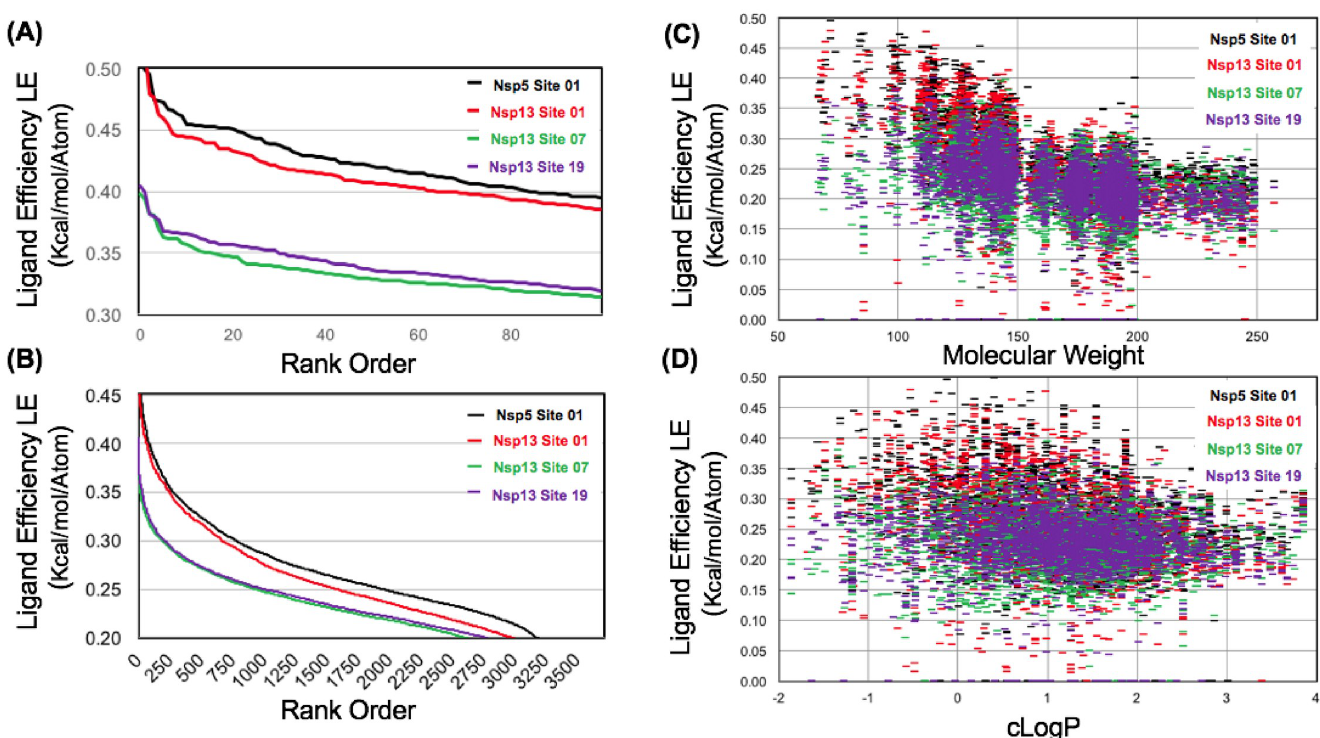
Fig 12. Ligand efficiency for favorable binding sites on Nsp5 Mpro and Nsp13 helicase from computational fragment screening. Data is shown for ligand efficiency (A) and (B) comparing several sites using the entire FRAG3700 library. Ligand efficiency data is also shown as a function of fragment molecular weight (C) and calculated LogP